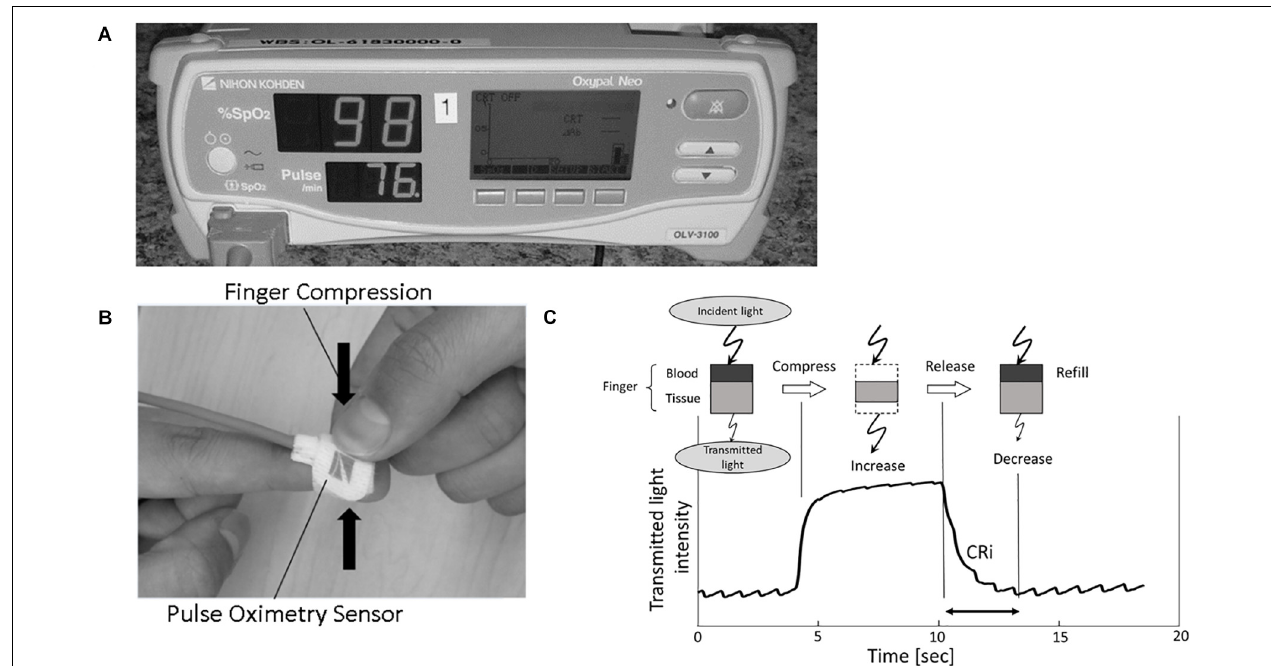
FIGURE 1 | (A,B) Images display the modified pulse oximeter device and finger sensor. (C) Schematic showing device functioning. Incident light is transmitted through the patient fingertip. During fingertip compression, blood exits the fingertip and TLI increases. TLI falls as blood returns to the digit during capillary refill. CRi, Capillary Refill index; TLI, transmitted light